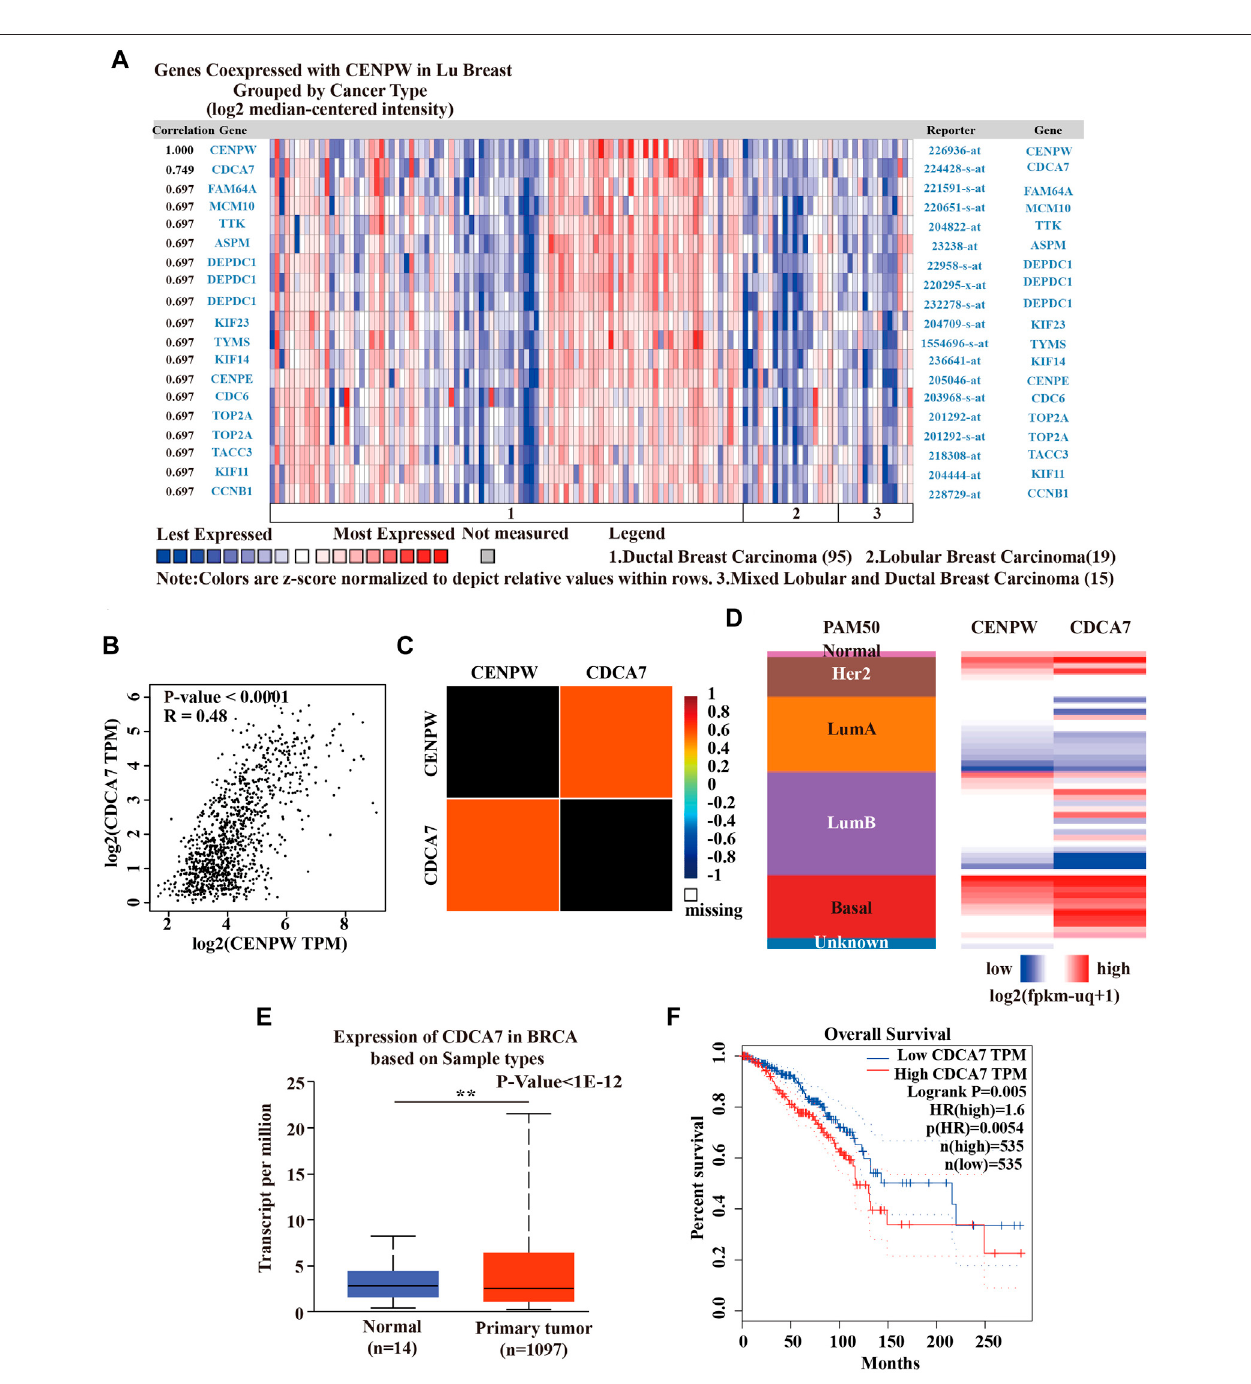
FIGURE 6 | Coexpression analysis of CENPW . (A) Coexpression pro fi le of CENPW derived from the Oncomine database. (B) The relation between CENPW and CDCA7 expression in breast carcinoma in GEPIA website and (C) the bc-GenExMiner database. (D) Heat map of CENPW and CDCA7 expression across PAM50 subtypes by UCSC Xena website. (E) The CDCA7 expression of breast cancer in Ualcan database. (F) The OS status according to the CDCA7 expression in GEPIA database. * p < 0.05, ** p < 0.01 between the compared groups.